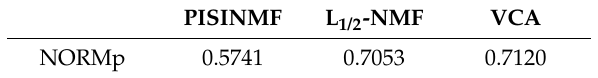
Figure 9. Sum of difference values between central pixels and all surrounding pixels in the local window. Table 2. The error values of the intrinsic structure of estimated abundance.